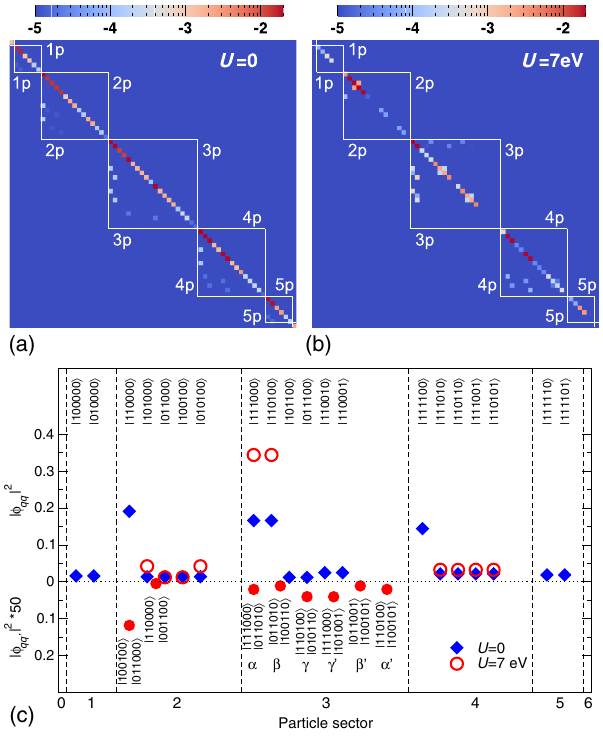
FIG. 8. Local-state behavior of the minimal Hamiltonian via the 2 connecting Fock states q , q 0 . (a,b) slave-boson weights j ϕ qq 0 j Weight matrix in q , q 0 -space covering the N ¼ 0 ; … ; 6 particle sectors N p for weights greater than 10 − 5 : (a) U ¼ 0 and (b) U ¼ 7 eV. (c) Dominant diagonal weights (along the positive axis) for U ¼ 0 and for U ¼ 7 eV, and dominant off-diagonal weights (along the negative axis) within each particle sector for U ¼ 7 eV (filled